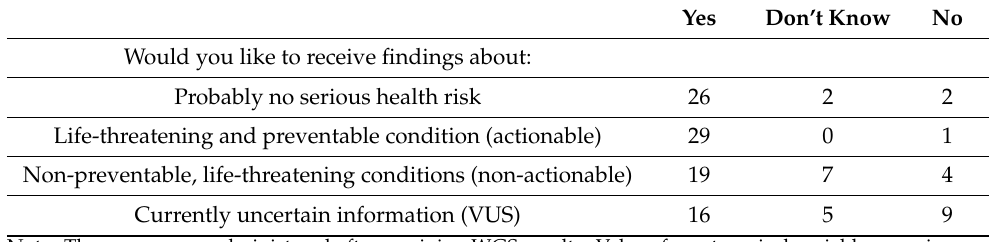
Table 6. Respondents’ attitudes towards receiving various categories of WGS findings (post, n = 30). Yes Don’t Know No Would you like to receive findings about: Probably no serious health risk 26 2 2 Life-threatening and preventable condition (actionable) 29 0 1 19 7 4 5